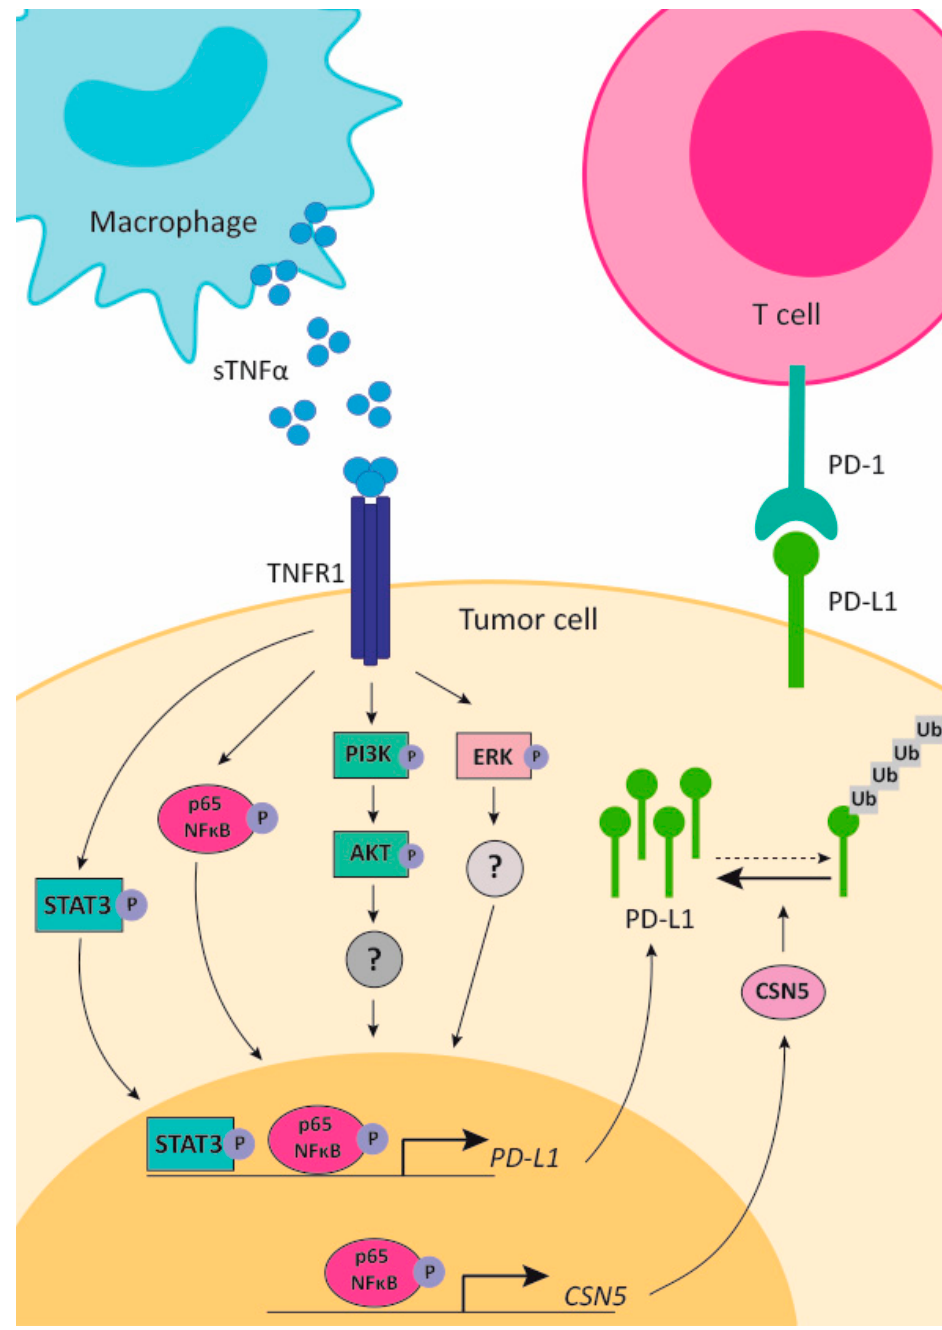
Figure 1. Tumor necrosis factor alpha (TNF α ) modulates programmed death ligand 1 (PD-L1) expression transcriptionally and post-transcriptionally. TNF α , acting through TNF α receptor 1 (TNFR1), activates extracellular signal-regulated kinase (ERK) and phosphatidylinositol-3-kinase (PI-3K/AKT) pathways and nuclear factor kappa B (NF- κ B) and signal transducer and activator of transcription 3 (STAT3) transcription factors that promote PD-L1 gene transcription. In addition, NF- κ B also induces transcription of the deubiquitinase COP9 signalosome 5 (CSN5), which promotes PD-L1 protein stability. Ub: ubiquitin, sTNF α : soluble TNF α